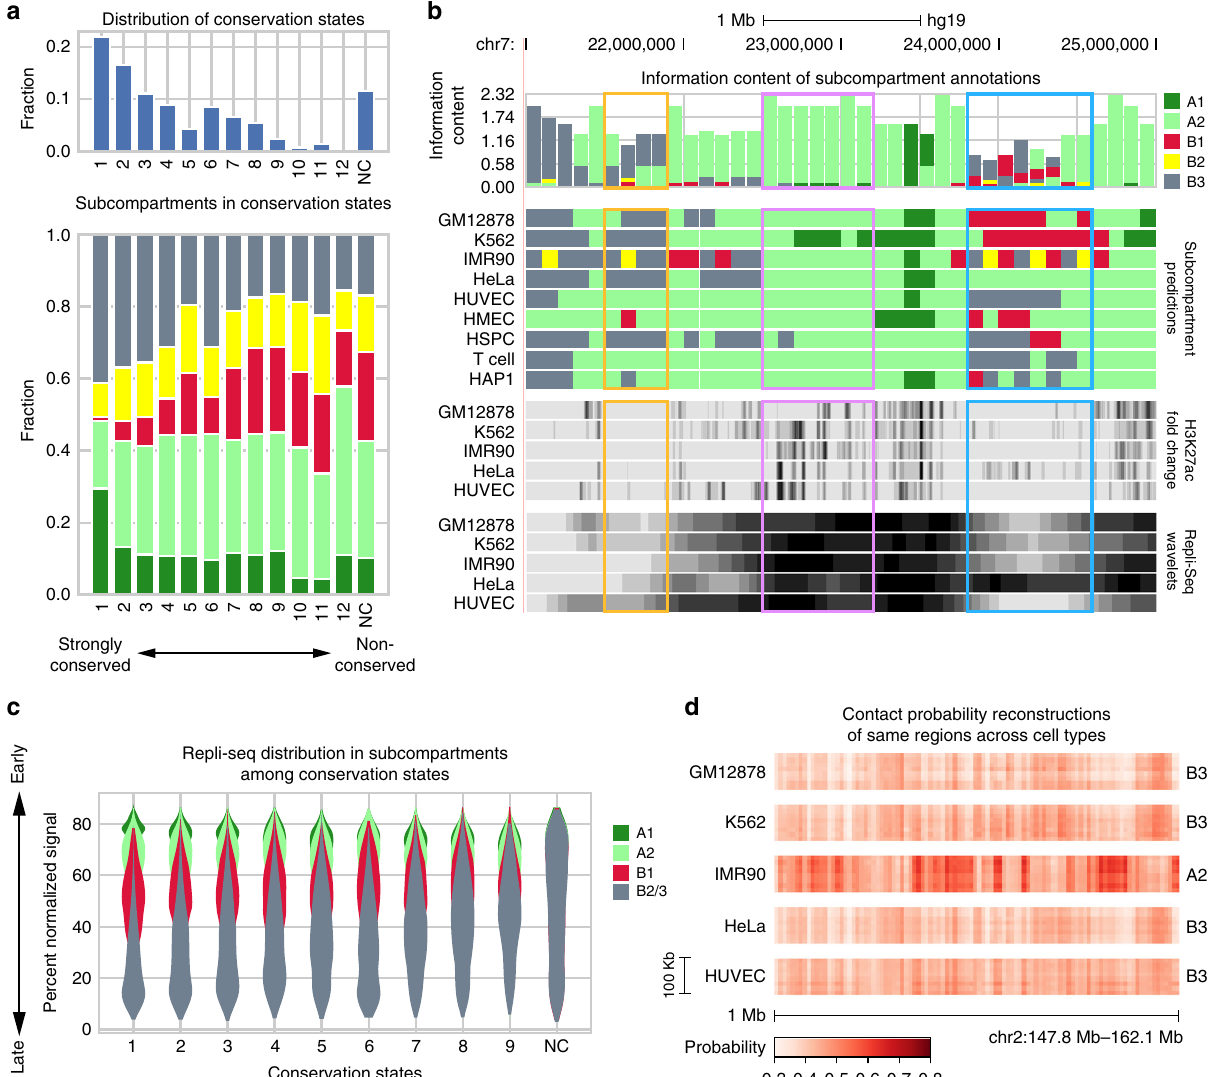
Fig. 4 SNIPER allows comparisons of subcompartments across different cell types. a (Top) Distribution of thirteen conservation states in the genome. (Bottom) Distribution of subcompartment regions in each conservation state. b UCSC Genome Browser shot displaying the information content (IC), cross cell type predictions, H3K27ac fold change, and smoothed Repli-seq wavelets of each 100 kb region. Subcompartments offering the most information, associated with taller bars in the IC track, are more conserved across nine cell types. Highlighted color boxes show three regions with distinct patterns across cell types. c For each conservation state, we show Repli-seq signal distribution in the most frequent subcompartment annotations among nine cell types at each 100 kb region. Regions in conservation state 1 are the most conserved, re fl ected by low variance of Repli-seq signal in each subcompartment. Regions in the NC state are the most dynamic, suggesting multiple annotations for a single chromatin region and high variance in Repli-seq signal. d